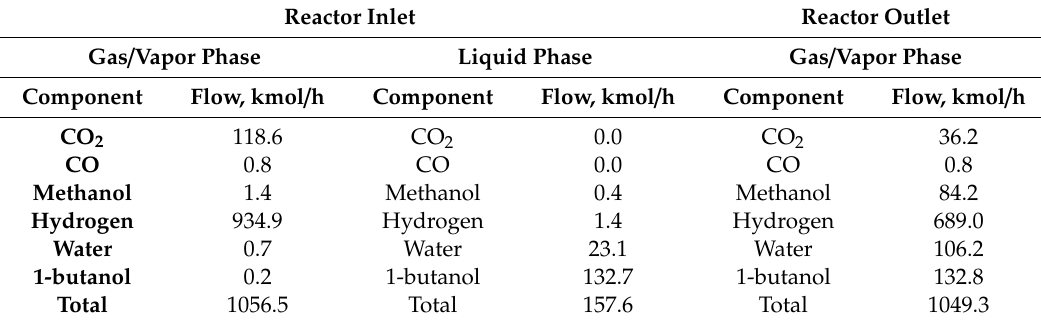
Table 4. Composition of the gas / vapor and liquid phases in the reactor inlet and outlet streams of the liquid-phase process with 1-butanol solvent. Reaction conditions are 180.0 ◦ C and 50.0 bar, and the reactor is modelled as a continually-stirred tank reactor (CSTR) with the full equilibrium approach of the CO 2 hydrogenation to methanol and the reverse-water gas shift reactions.